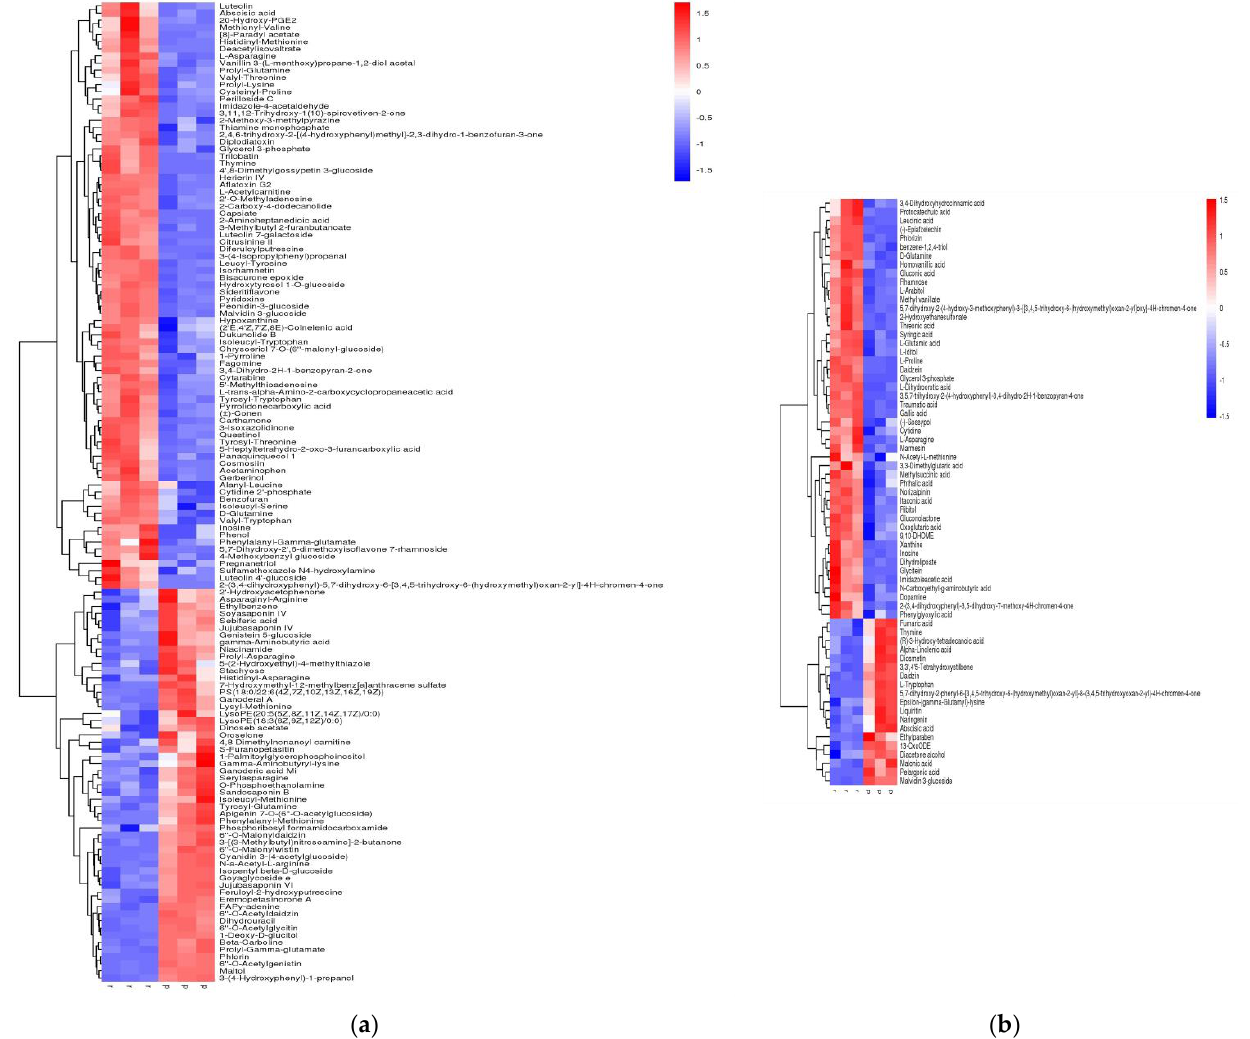
Figure 3. Heat map of hierarchical cluster analysis of differential metabolites in raw and cooked black beans. ( a ) Positive ion mode. ( b ) Negative ion mode.